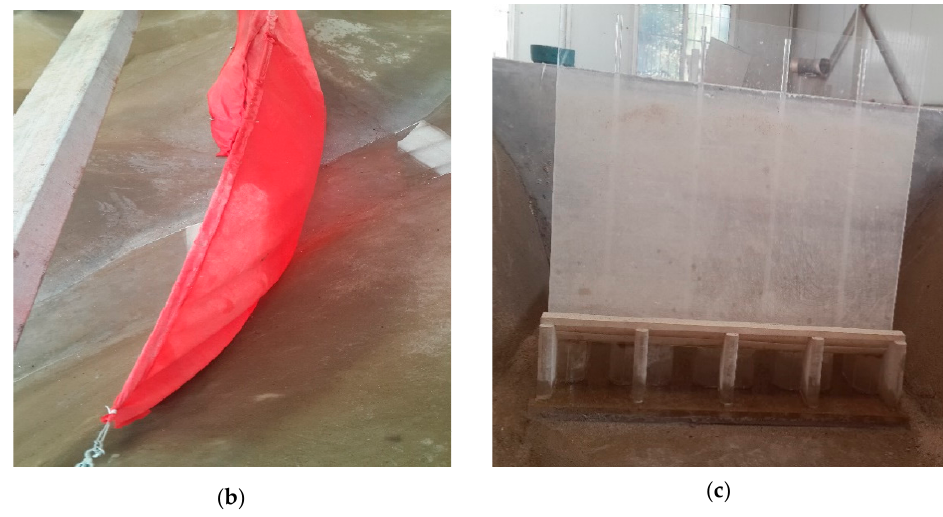
Figure 6. Schematic of TCC experiment: ( a ) Test model terrain; ( b ) TCC; ( c ) Water intake.